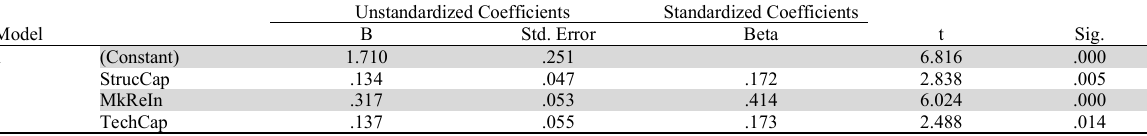
The results of regression